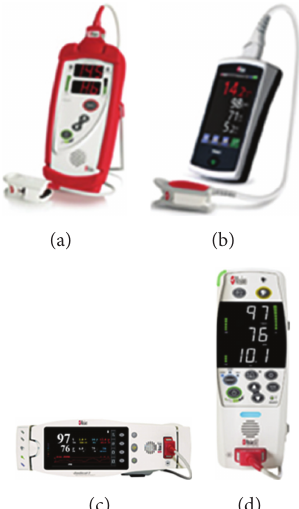
Figure1:Handheldspotcheckdevices,(a)Pronto;(b)Pronto-7,and continuous monitoring bedside devices, (c) Radical-7 and, (d) Rad-